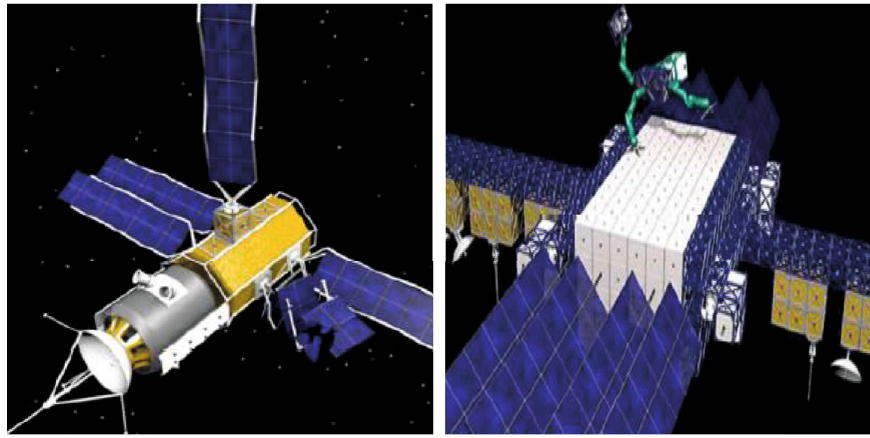
Figure 1: Solar array and platform extension of iBoss through in-orbit